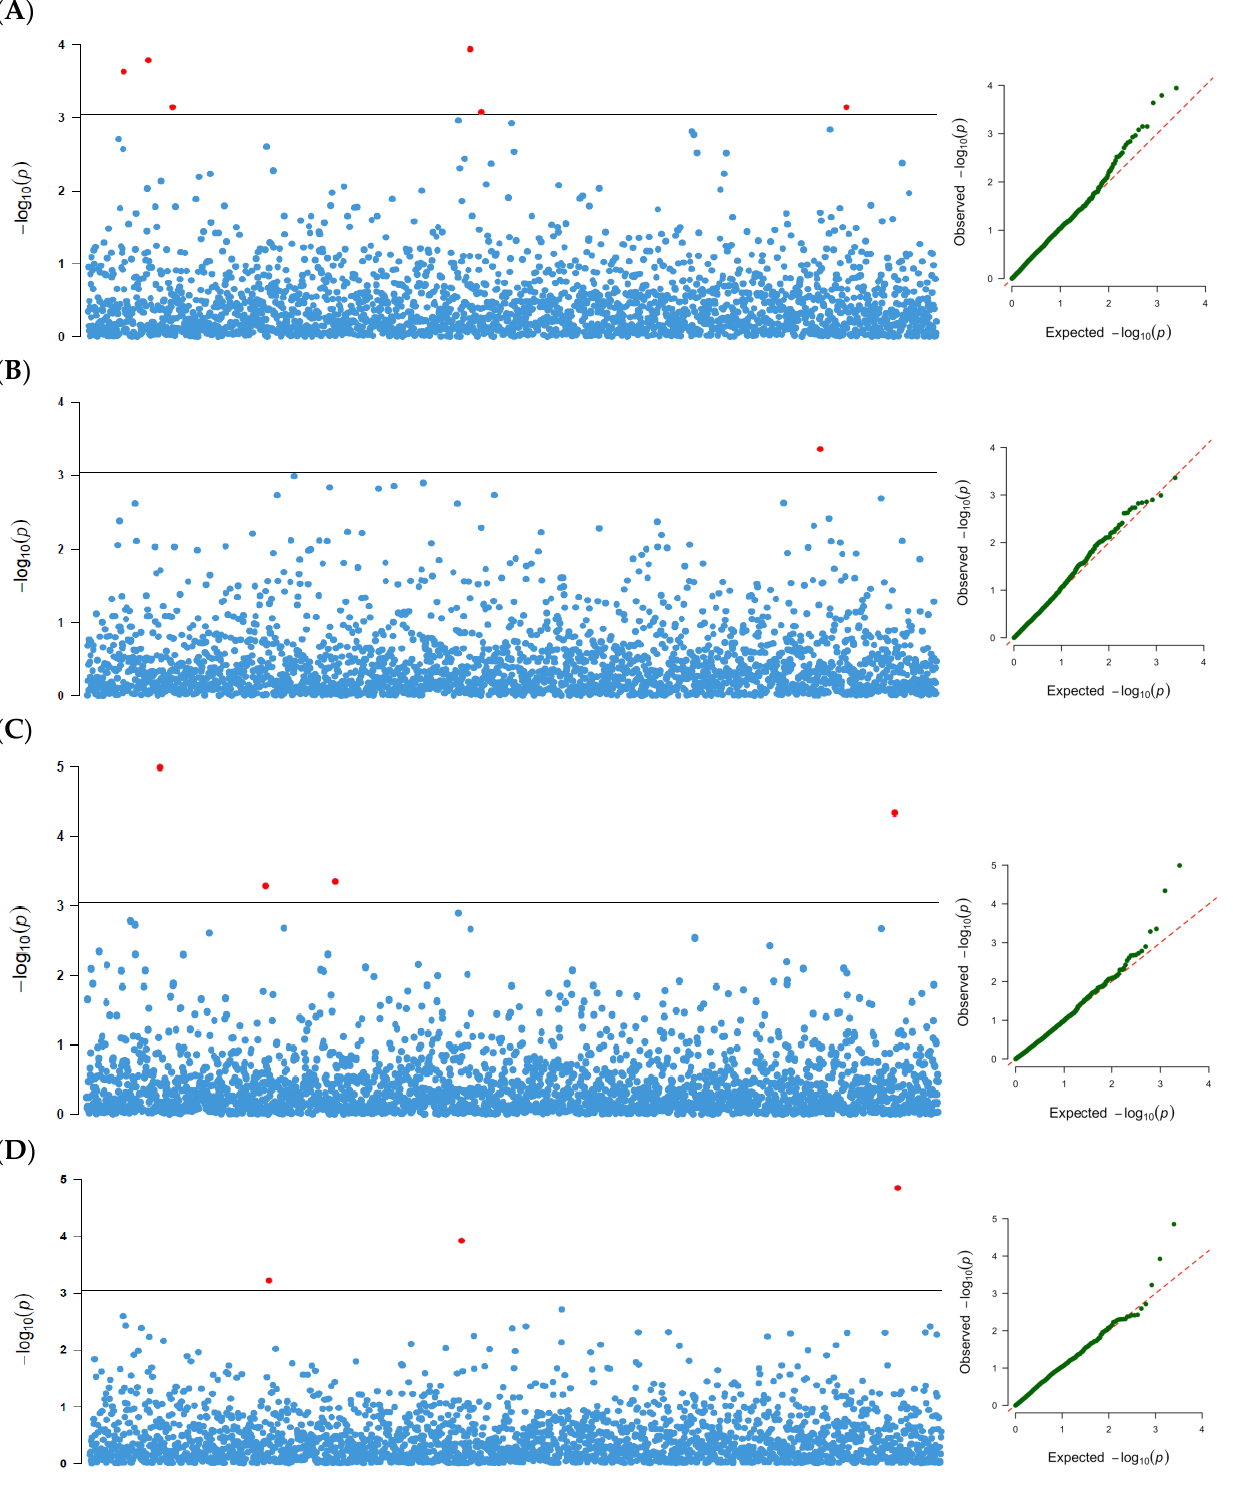
Figure 4. The Manhattan plots and Q–Q plots of the DArTSeq SNP-based associations mapping in the combined test environments analysis for: ( A ) hundred seeds weight (HSW), ( B ) seed length (SL), ( C ) seed thickness (ST), and ( D ) seed width (SW) using the GLM approach.